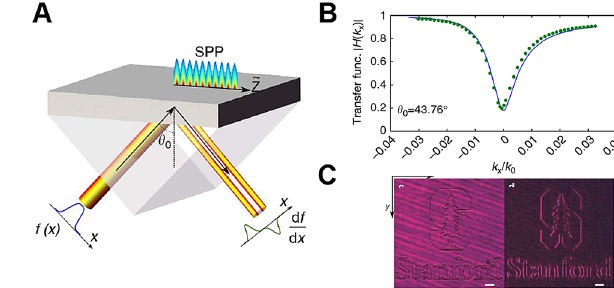
Figure 10: (A) The structure of a surface plasmon-based first-order spatialdifferentiatorconsistingof aAgfilmontopoftheglassinthe Kretschmann configuration [42]. (B) The fi rst-order spatial differ- entiatoropticaltransferfunction(OTF)obtainedbytheexperimental measurement (dotted lines) and the numerical fi tting (solid lines). (C) Edge detection of the Stanford tree logo and the letters as the incident image (left panel) using the plasmonic structure shown in (A). The re fl ected intensity image is shown in the right